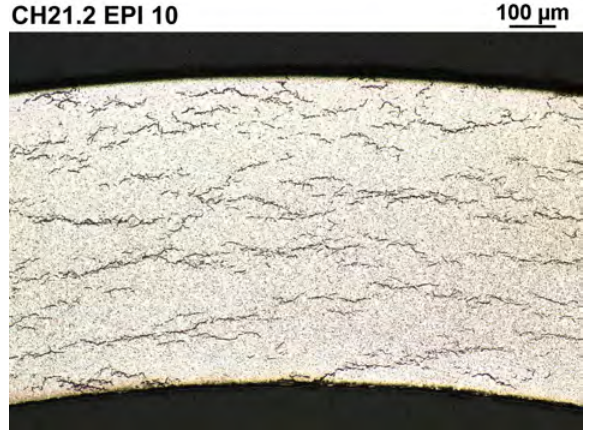
Figure 6. Sample CH21 was prepared using method- ology for uniform distribution of hydrides.